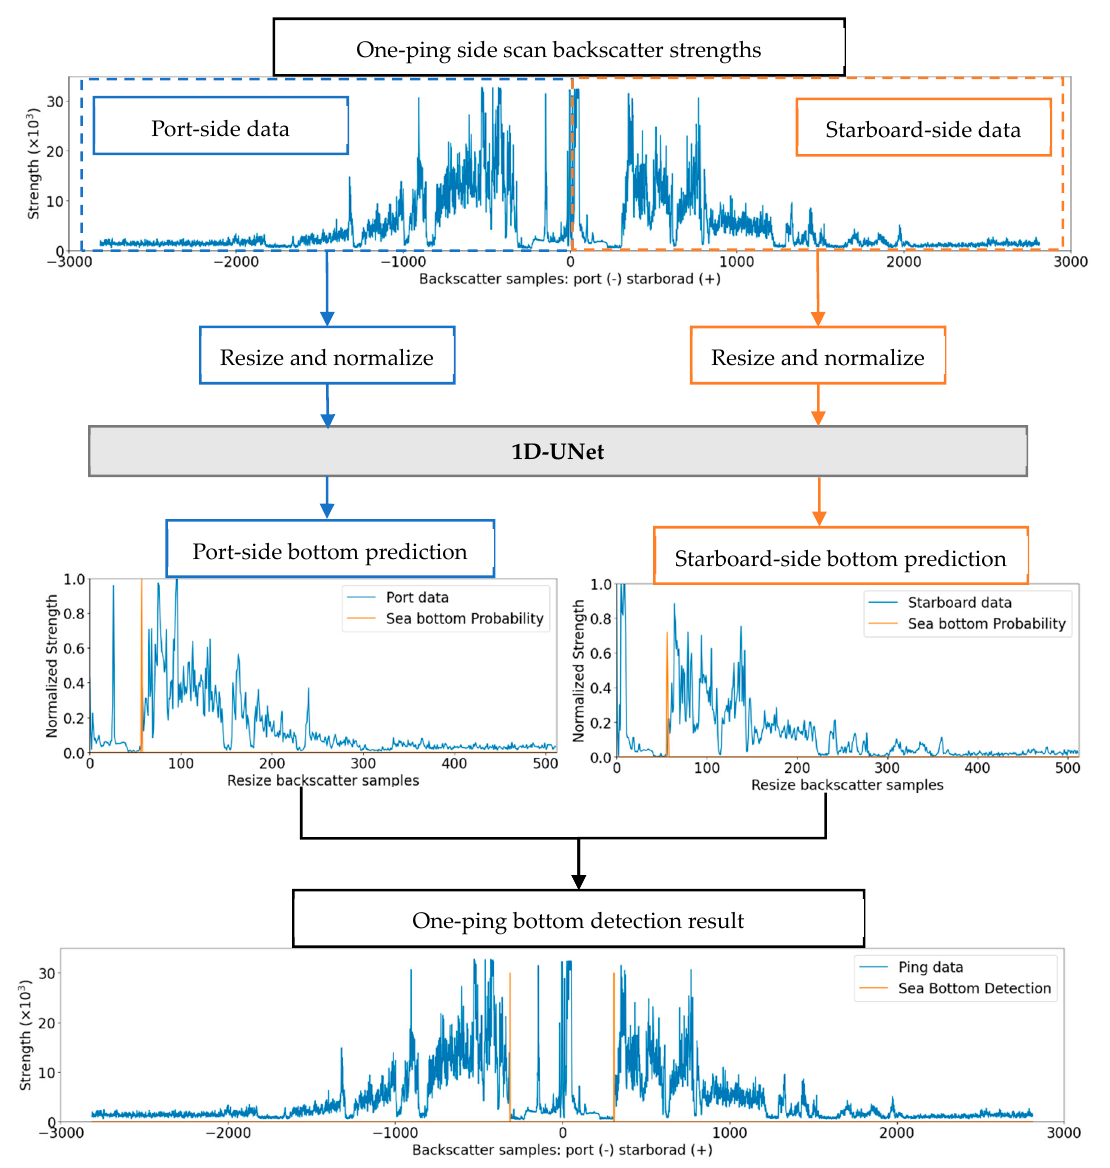
Figure 5. Bottom detection result for ping data obtained by using the trained 1D-UNet model. Each side-scan ping has the port and starboard part. The port-side and starboard-side data should be separately processed. The port-side (starboard-side) backscatter strength sequences need to be resized and normalized as the input data. Then, the bottom positions on both sides are predicted using 1D-UNet. After determining the sea bottom positions of the port-side and starboard-side backscatter strength sequences, the sea bottom of the ping data can be obtained.